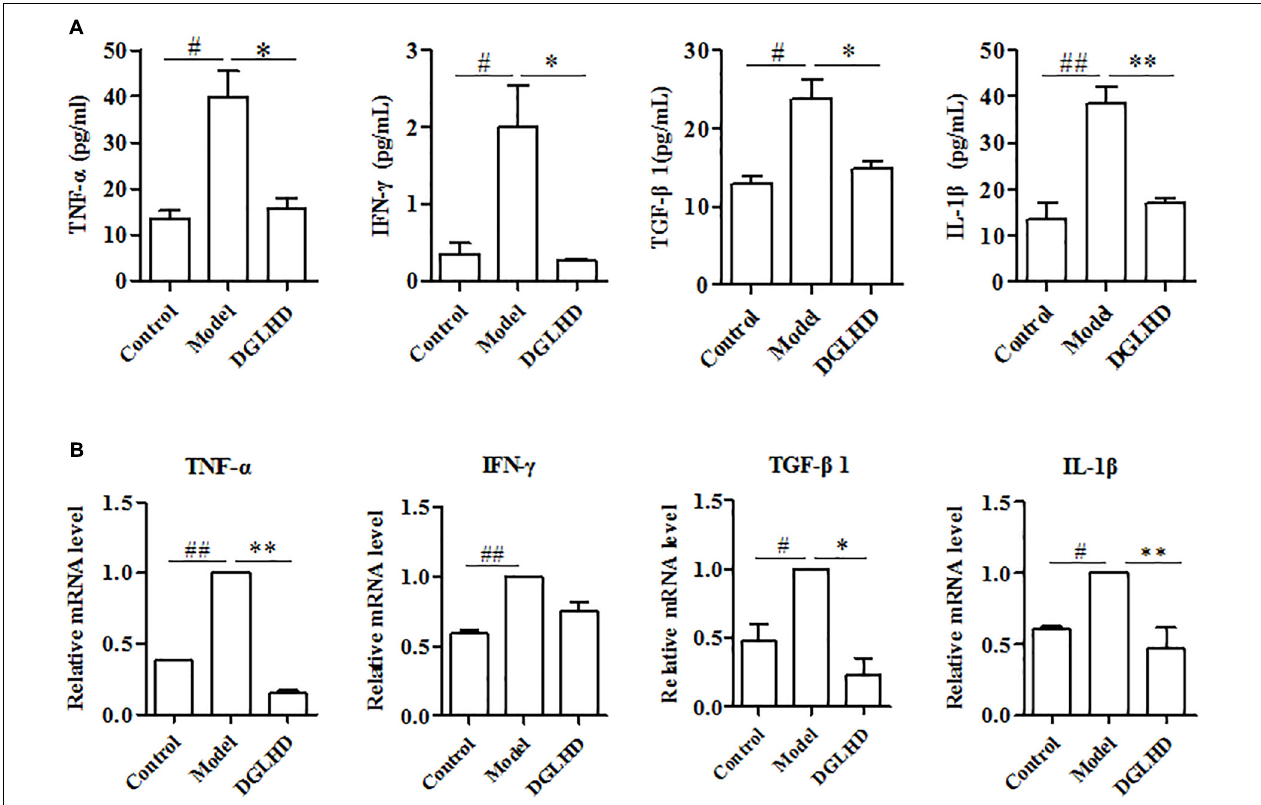
FIGURE 5 | Dangguiliuhuang decoction diminished local and systemic inflammation in hepatic fibrosis mice. Liver and serum were separated from control and fibrotic mice given water or DGLHD (5.0 g/kg) at the indicated time. (A) Secretions of TNF- α , IFN- γ , TGF- β 1, and IL-1 β in serum. (B) mRNA expressions of TNF- α , IFN- γ , TGF- β 1, and IL-1 β were analyzed in liver by qRT-PCR. β -actin was used as the internal reference. Data are expressed as mean ± SEM ( n = 4–5). # P < 0.05, ## P < 0.01 compared to Control. ∗ P < 0.05, ∗∗ P < 0.01 compared to